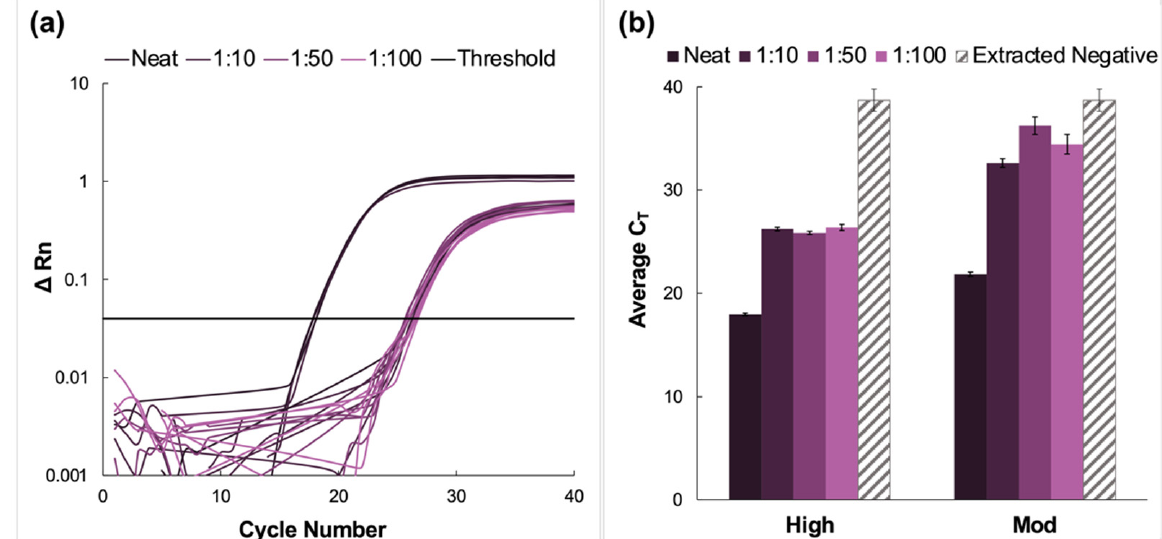
Figure 3. Amplification data obtained from pooling experiments using fresh saliva spiked with clinical nasopharyngeal swab samples. ( a ) A representative normalized amplification plot obtained from RT-PCR analysis of the extracted RNA (high viral titer). ( b ) A summary of the CT data. Dilution ratios increase from left to right. In this case, there was amplification in extracted negative samples ( n = 5). For high viral titer dilution pools, Tukey’s multiple comparison test determined that although the data obtained for the 1:10 and 1:100 dilutions were statistically different ( p < 0.0001), there was no significant difference between the average CT values obtained for the 1:50 compared to the 1:100 dilutions ( p = 0.7520). There were also no statistically significant differences when neat samples were compared to the dilution pools ( p < 0.0001), nor for 1:10 vs. 1:50 and 1:100 dilutions ( p = 0.0008 and <0.0001, respectively). The average CT values for all moderate dilution pools were found to be statistically different when compared using Tukey’s test ( p < 0.0001 for neat vs. all dilu- tions and 1:10 vs. 1:50 dilution pools. p = 0.0152 for 1:10 vs. 1:100 pools, and 0.0171 for 1:50 vs. 1:100 pools).